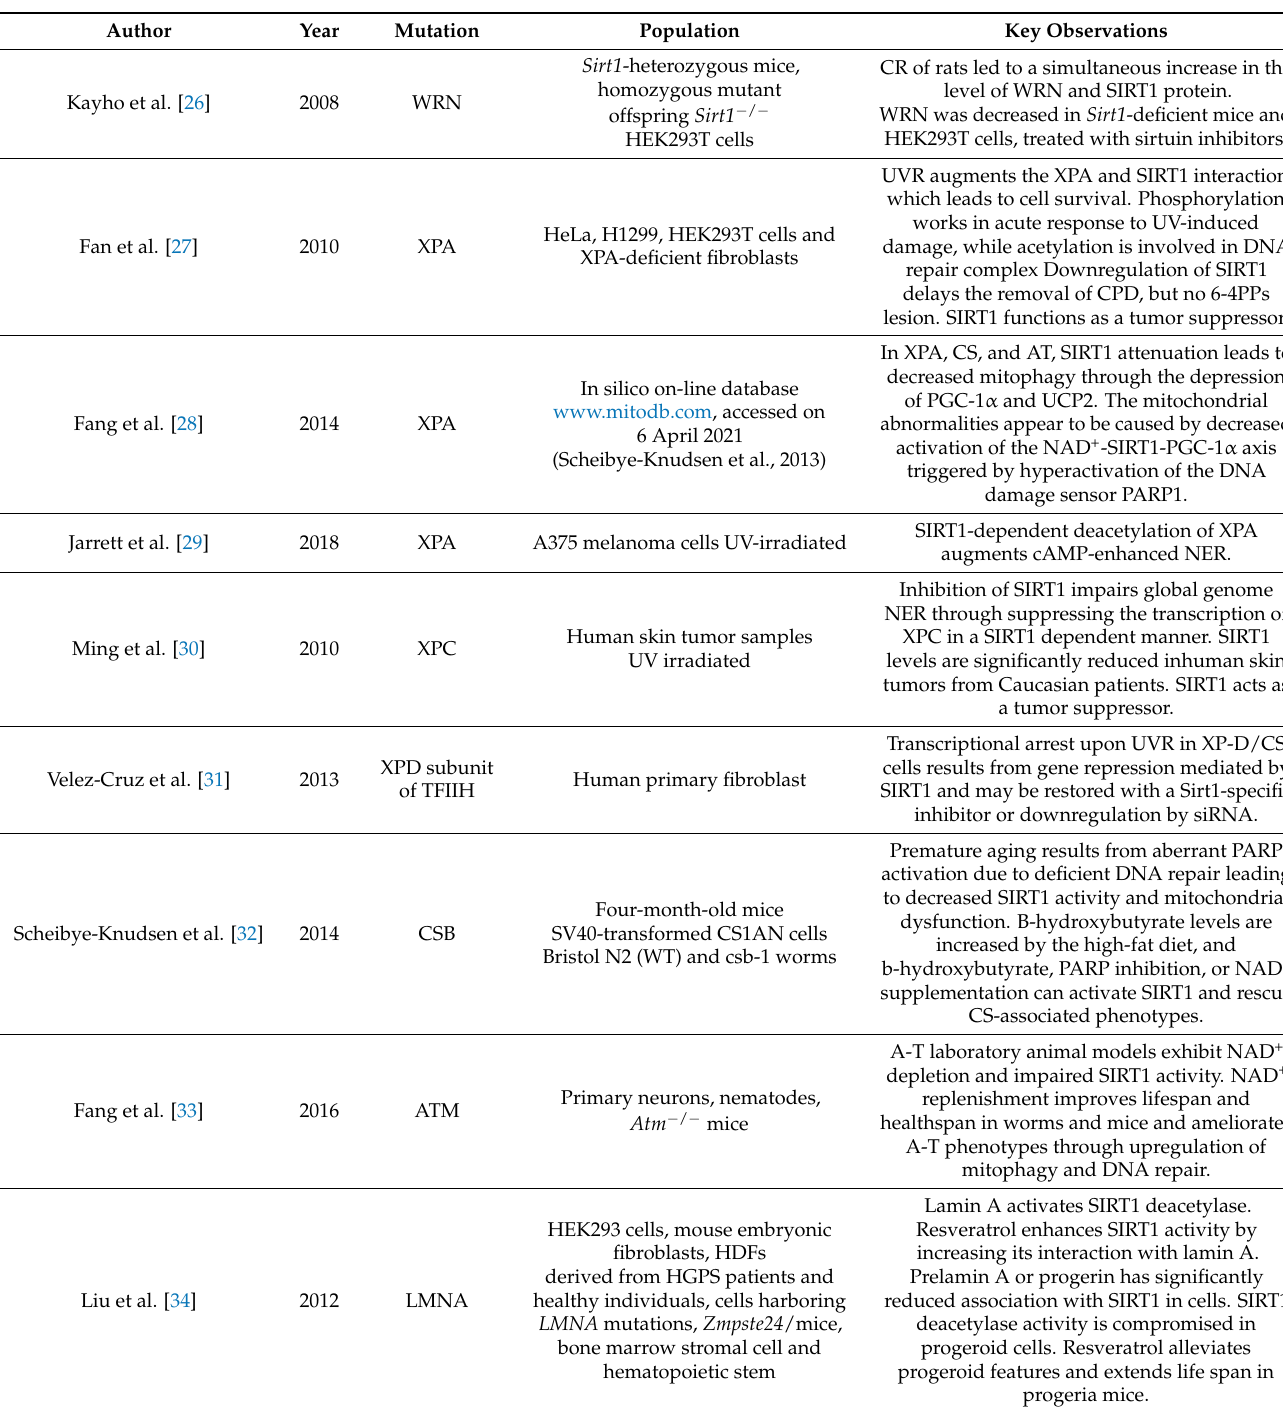
Table 2. Summary of the studies on SIRT1 relevance in progeroid